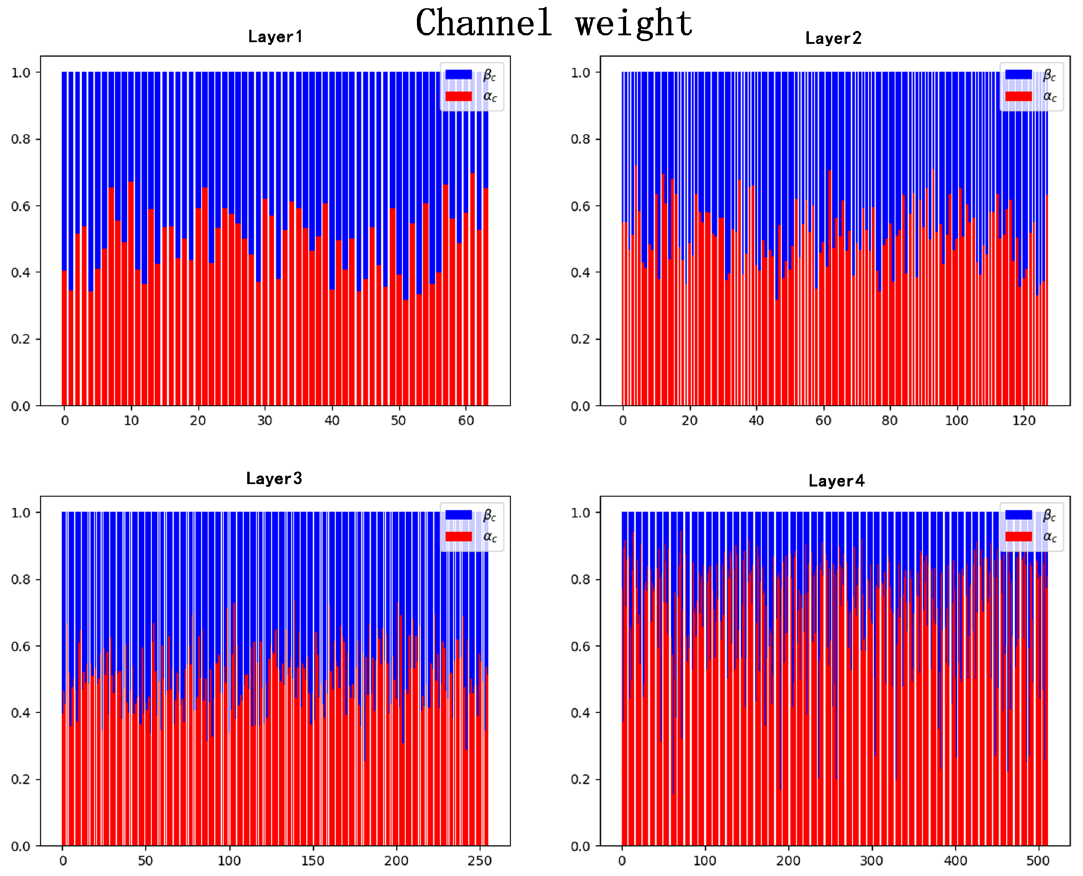
Fig. 8 Compare the weights of two heterogeneous networks on channel axis. Layer1, Layer2, Layer3, and Layer4 represent the output of model weights of the first, second, third, and fourth layers of the model